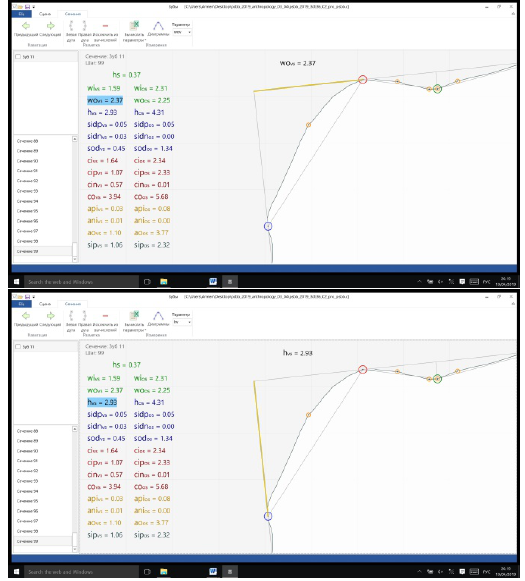
Figure 5. Linear parameters measured on contours of teeth for further